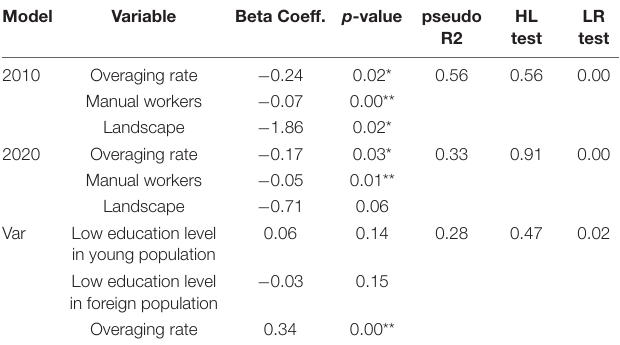
TABLE 3 | Summary of logit regression